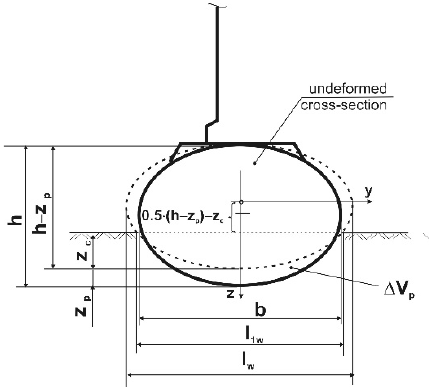
Figure 3. Deformation of the tire cross − section in the contact area (upgraded model). The width of the tire under load, l w , was calculated assuming that the perimeter of elliptical cross-section is the same for the no load/load conditions: 2 pp2 zzh2bl −⋅⋅+= . w